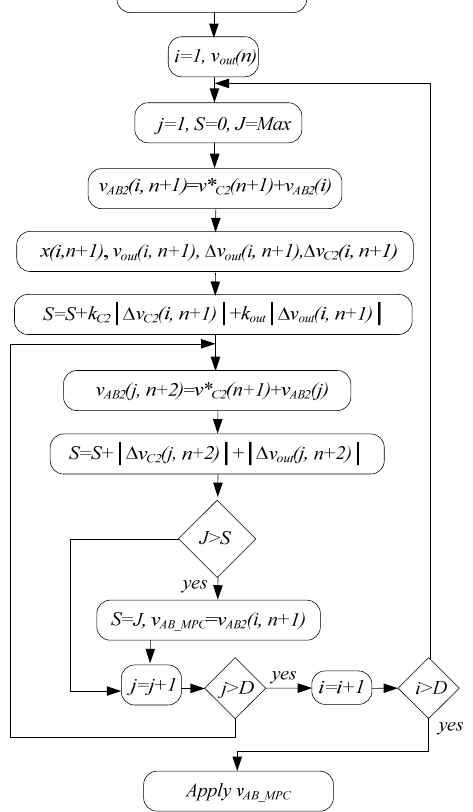
Figure 6. The procedure of activity diagram of the proposed iMPC in the case of p = 2.